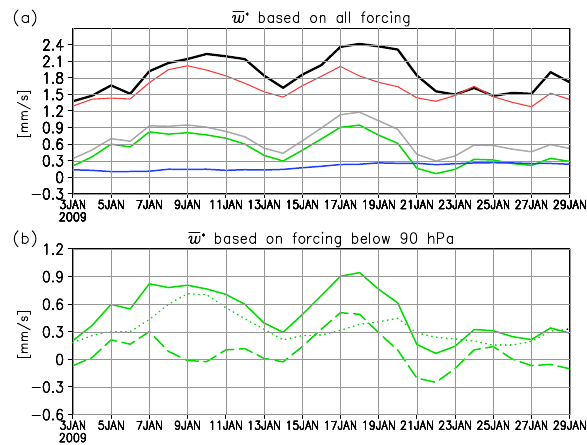
Fig. 5. As for Fig. 4, except for residual mean vertical wind (mms − 1 ) in the tropics averaged over 150–100hPa. (a) Observa- tions (black thick-solid line), forcing in the all regions (gray solid line), all regions including observed boundary values (red thin-solid line), global troposphere (green solid line), and global stratosphere (blue solid line). (b) Forcing in the global troposphere (green solid line; same as a ), northern hemispheric troposphere (green dashed line), and southern hemispheric troposphere (green dotted line). See Table 1 for details.